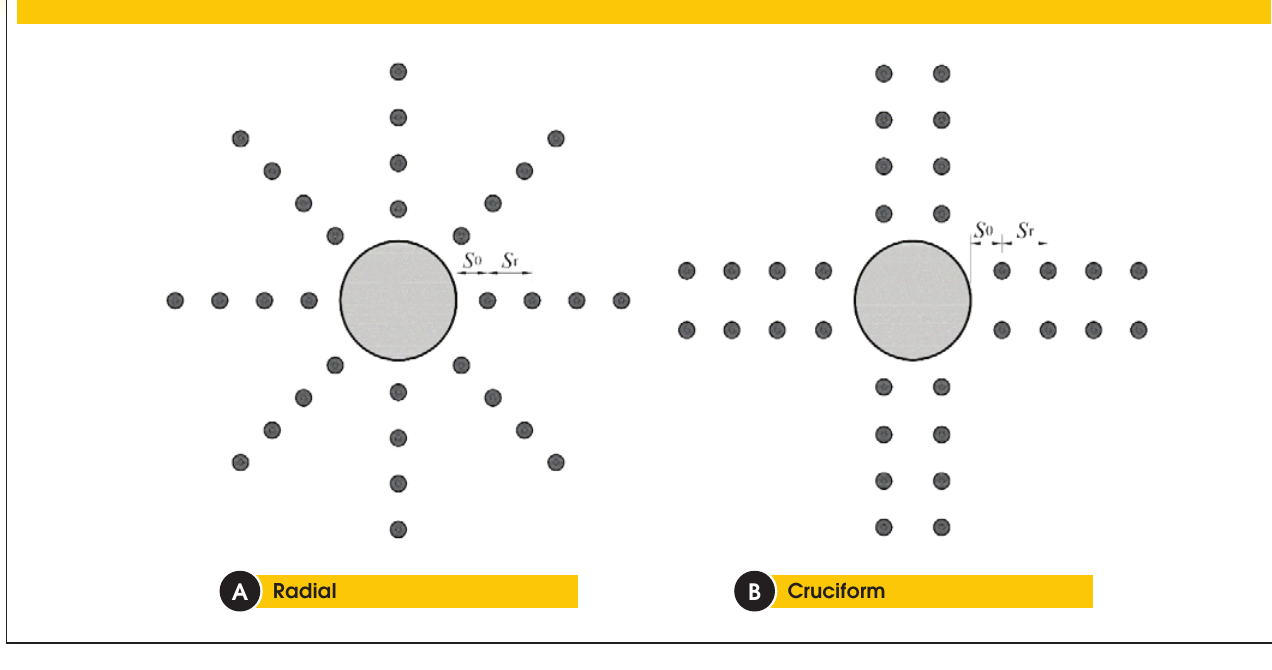
Figure 2 – Different arrangements for shear reinforcements